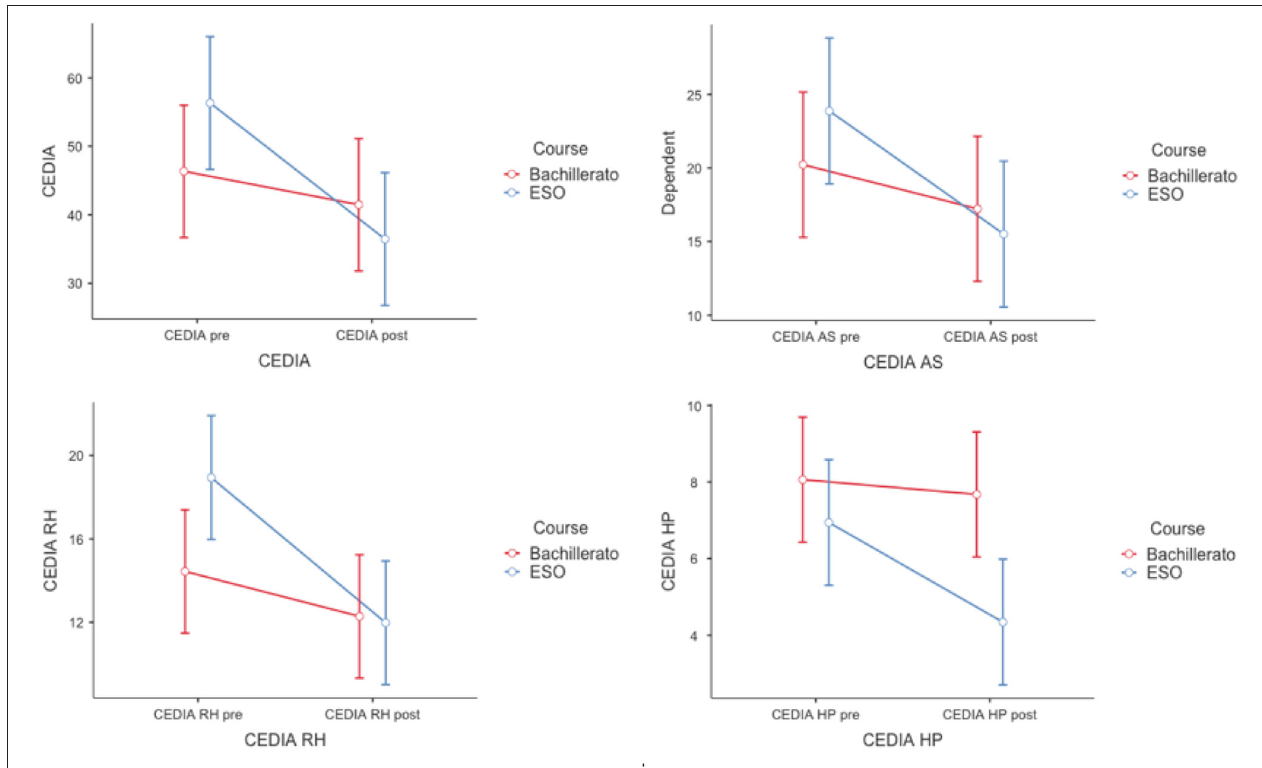
FIGURE 1 | Interaction plots of the interpersonal dificulties scale and subscales. Interaction plot with 95% confidence intervals around the cell means. CEDIA scale interaction reported in the text; Cedia subscales. AS, Assertivenes, [ F (1,49) = 2.65, p = 0.11]; RH, Heterosexual relationships, [ F (1,49) = 7.31, p = 0.009, η ² = 0.02, η ² p = 0.13]; HP, Public Speaking, [ F (1,49) = 4.20, p = 0.046, η ² = 0.02, η ² p = 0.08]. The RF (family relationships) and AM (Friends) subscales are not shown for reasons stated in the text.